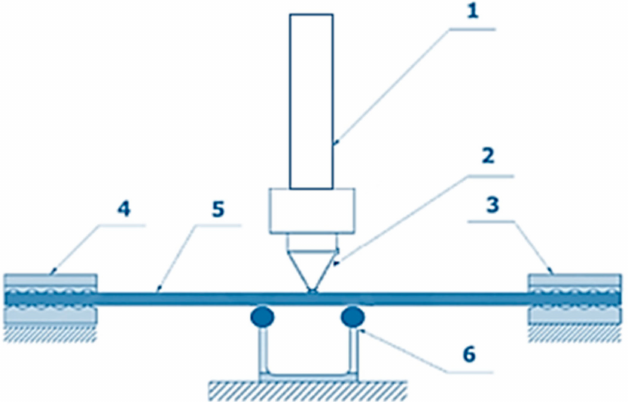
Figure 4. Testing equipment diagram: 1. hammer; 2. impactor; 3. fixed stretching jaw; 4. slid- ingstretching jaw; 5. conveyor belt test specimen; and 6. idler support